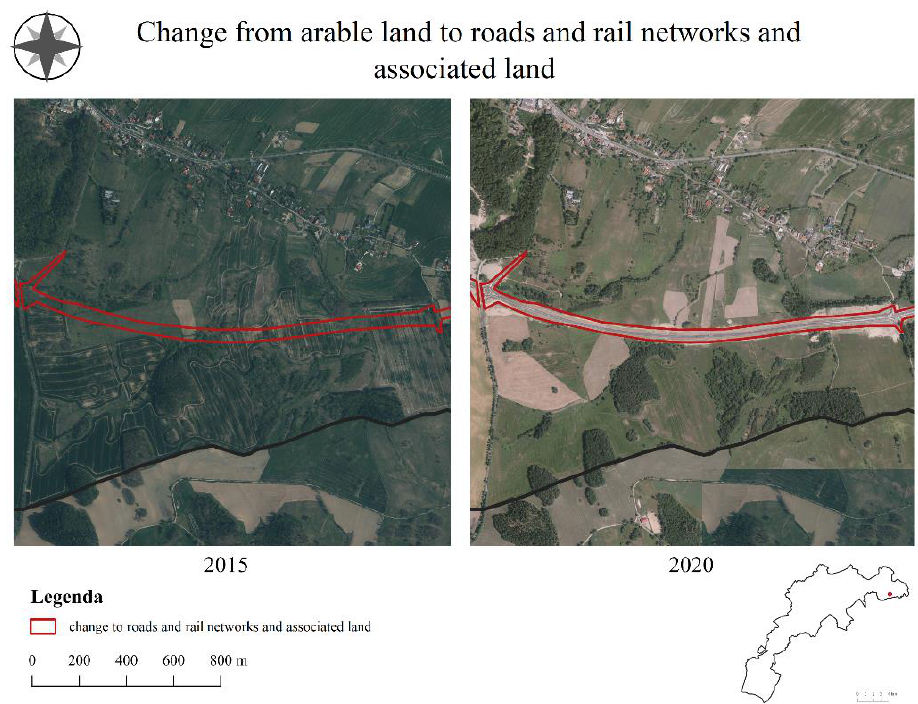
Figure 8. Development of transportation areas in the city of Jelenia Góra.